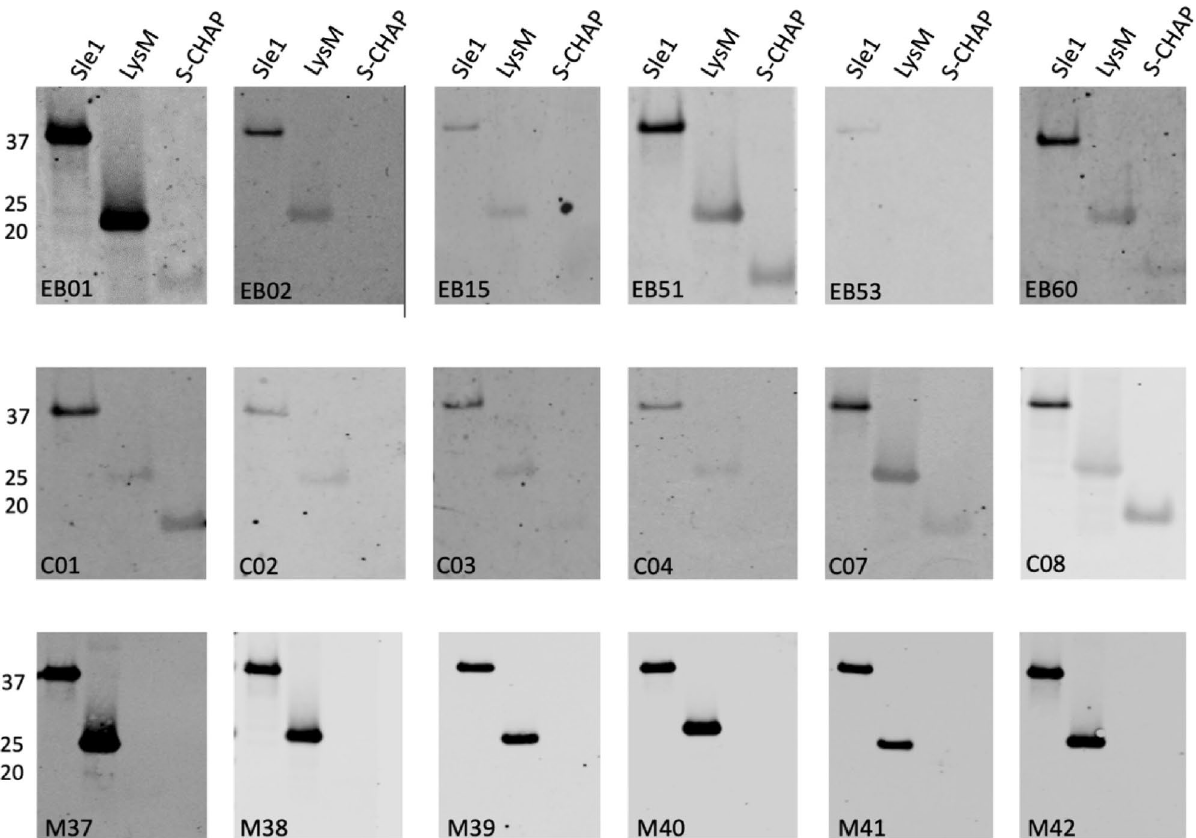
Figure 6. Specific binding of IgGs from EB patients, healthy volunteers and immunized mice to Sle1 and its LysM and S-CHAP domains. The purified full-size Sle1 protein and its LysM and S-CHAP domains were separated by LSD-PAGE and analyzed by Western blotting using sera from EB patients (top panels), healthy volunteers (middle panels) and mice immunized with Sle1 (bottom panels). The respective sera used for Western blotting are indicated in each panel. The molecular weights of Sle1 and its domains are indicated on the left (in kDa). For original Western blots see Supplemental Fig. 2D. The Western blotting experiments were replicated